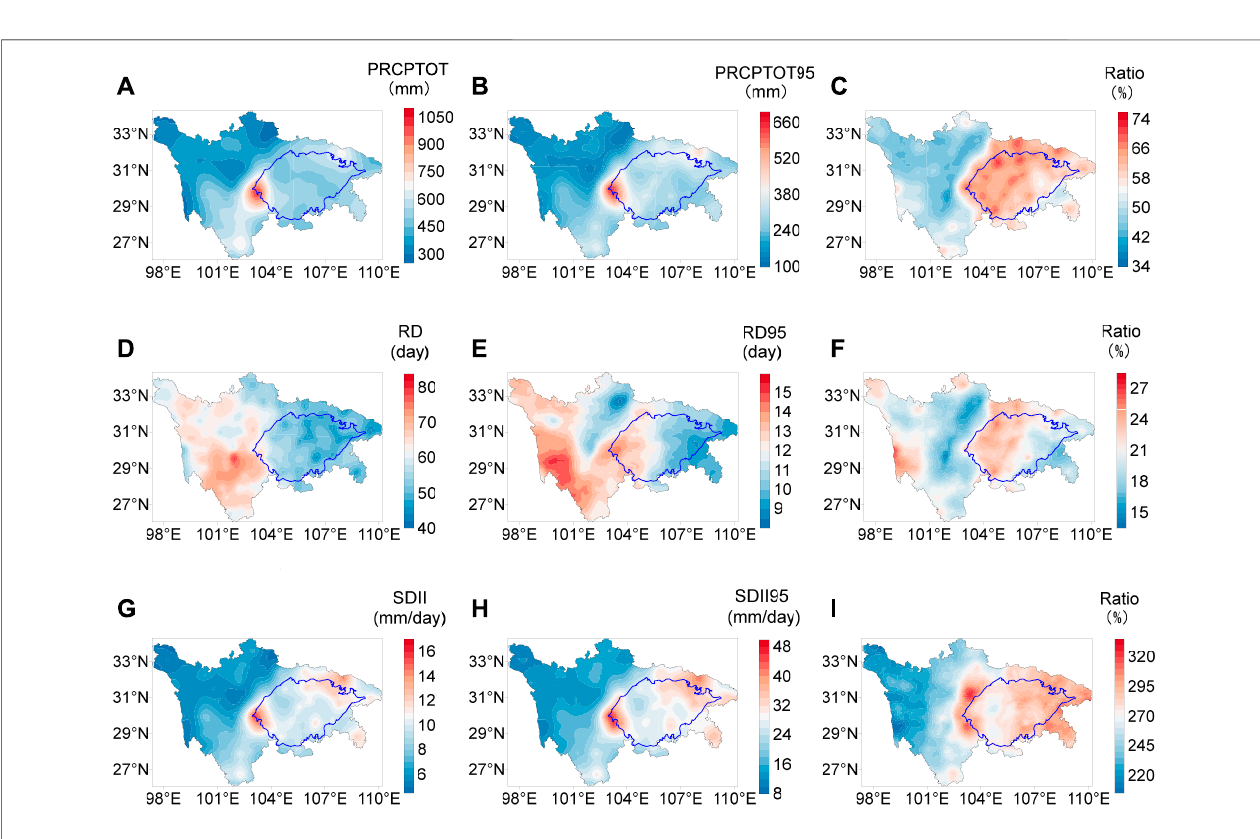
FIGURE 4 | Annual average distribution of all precipitation and extreme precipitation events in the Sichuan – Chongqing area: (A,D, and G) show all precipitation events; (B,E, and H) show extreme precipitation events; and (C,F, and I) show the ratios of extreme precipitation events to all precipitation events.